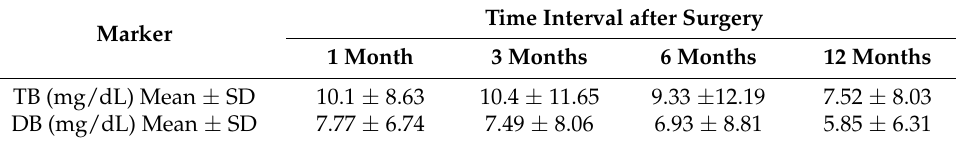
Table 1. Mean values of total and direct